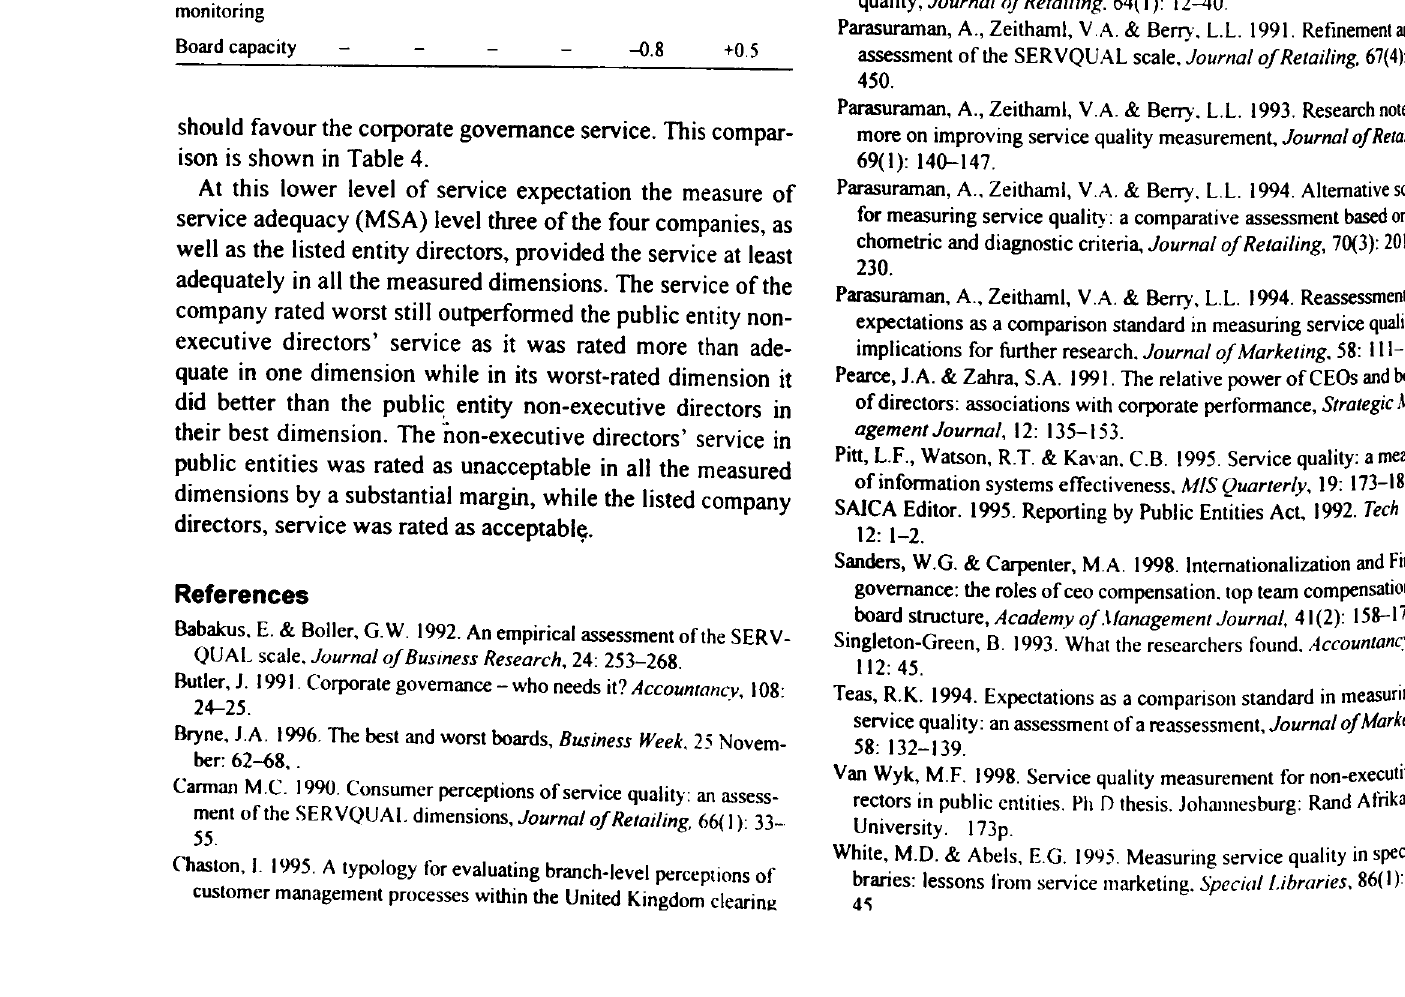
Table 4 Comparisons with the corporate governance